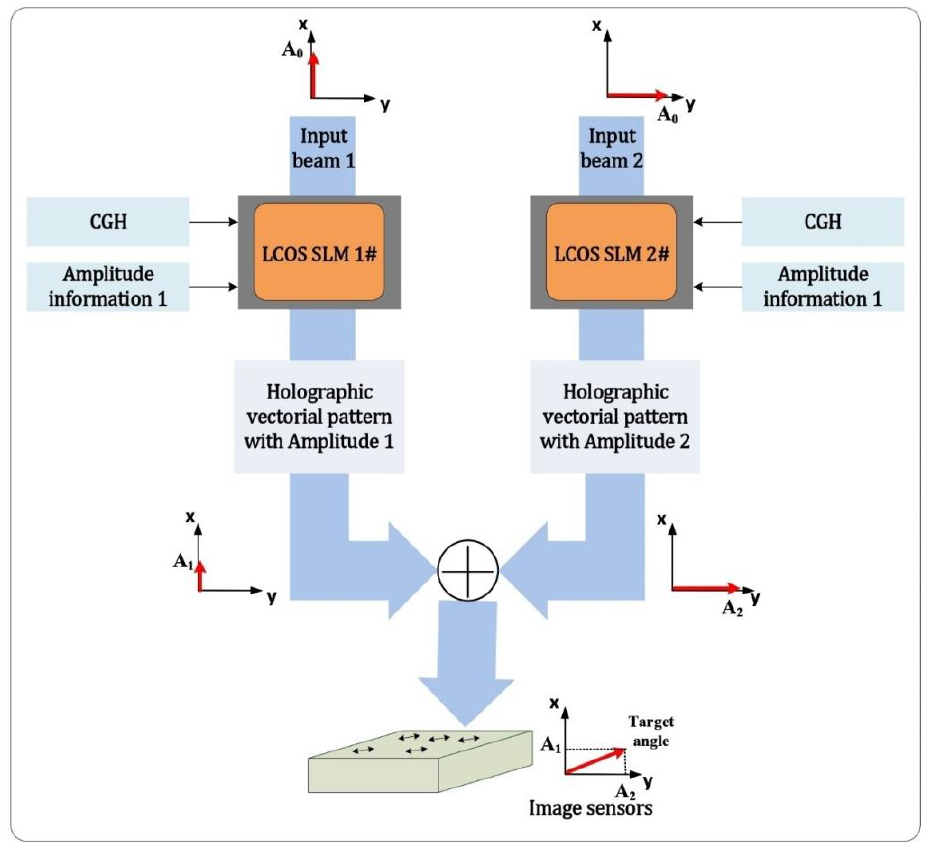
Figure 1. Schematic of the proposed method using two-beam parallel coding in combination. The information of the target image and amplitude are independently encoded onto the input beams to form the target polarization state.